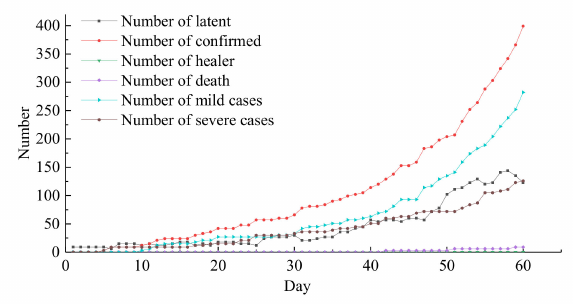
Figure 6. Self-hygiene protection